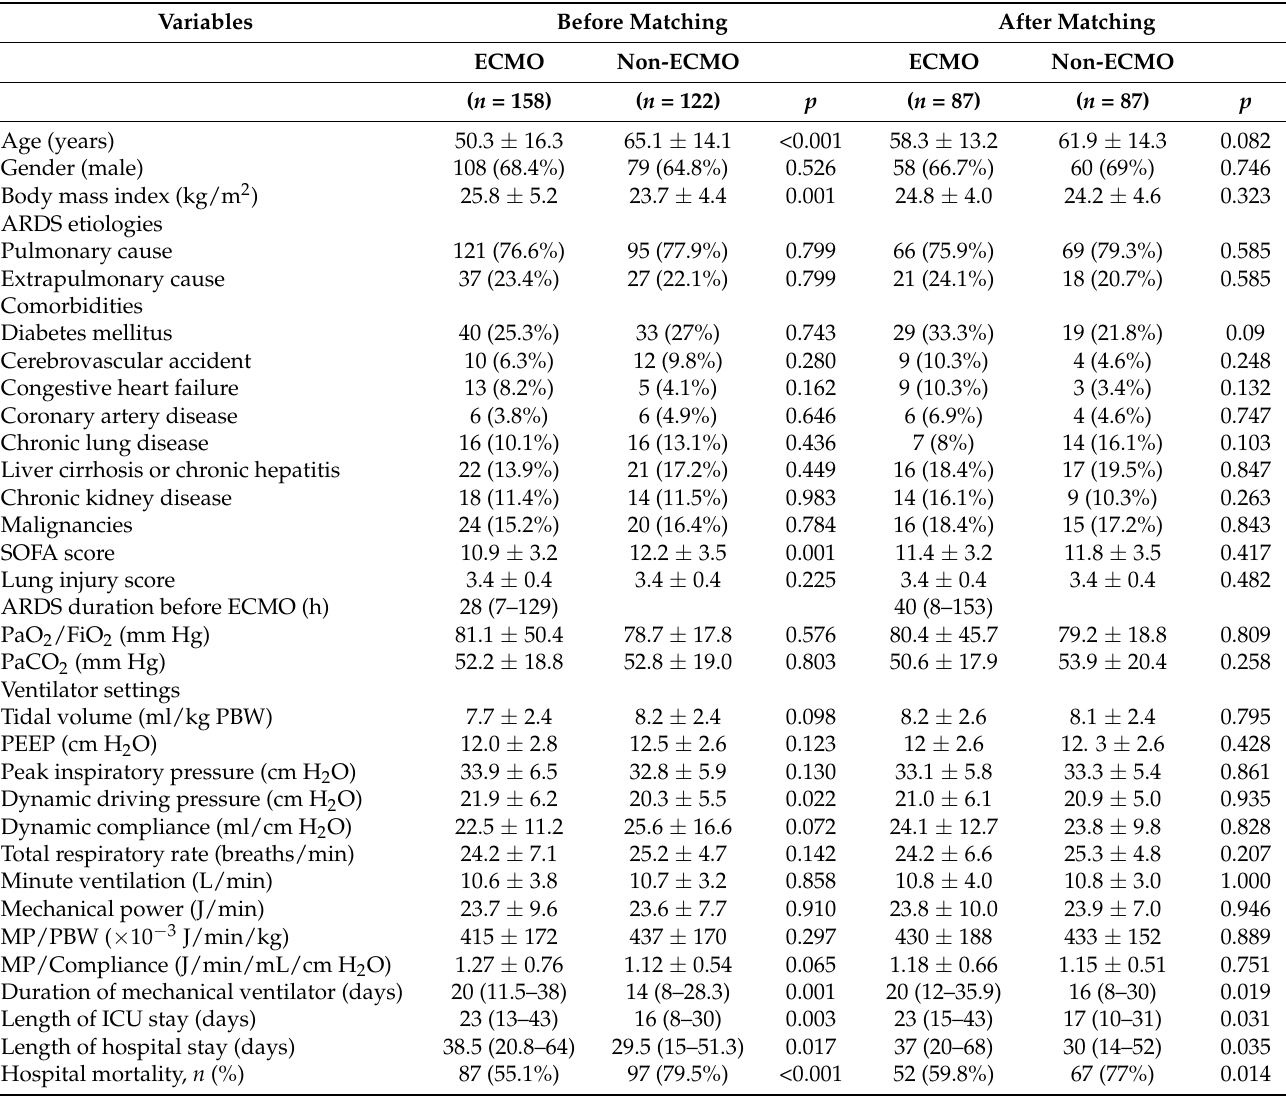
Table 1. Background characteristics of severe ARDS patients with or without ECMO before and after